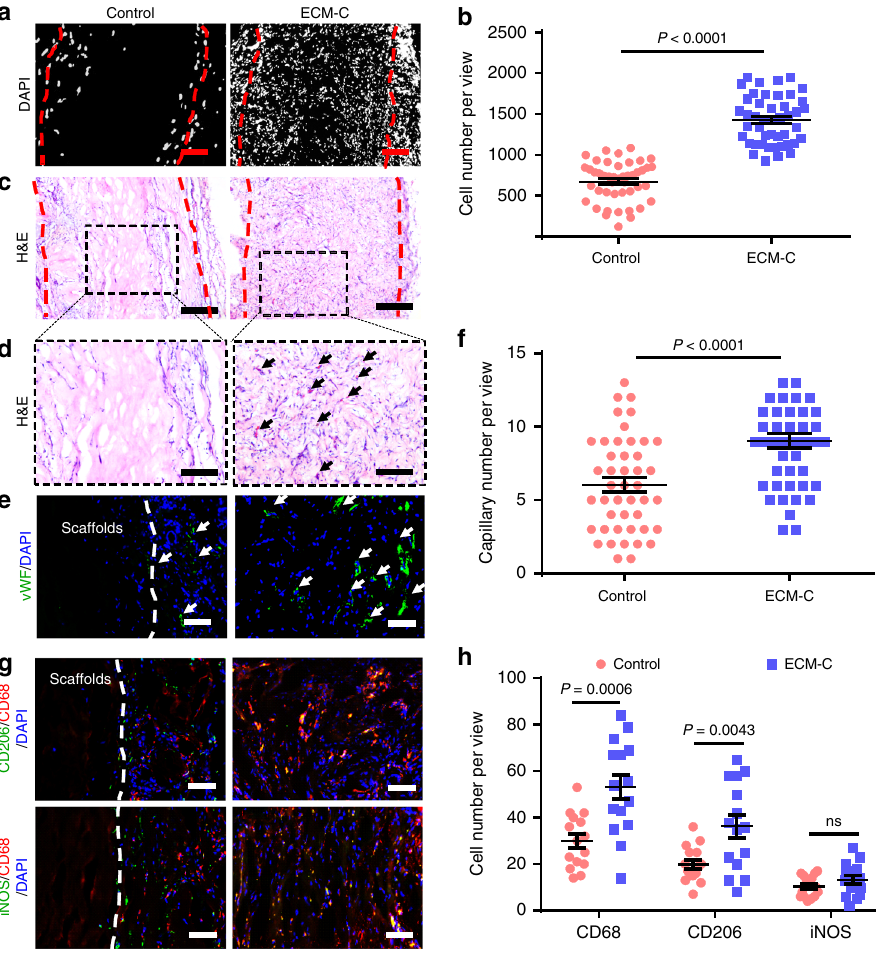
Fig. 4 Cell in fi ltration, vascularisation and immunogenic properties of ECM-C and control scaffolds in a rat subcutaneous implantation model at 2 weeks. a DAPI staining of the cross-sections showing cell in fi ltration within the scaffolds. b Quanti fi cation of cells within the scaffolds ( n = 45). c – e Optical images of cross-sections stained with H&E and immuno fl uorescently stained for vWF (green) showing cellularization and vascularisation within the scaffolds. The black and white arrows indicate the capillaries. The red dotted line indicates the edge of the scaffolds. f Quanti fi cation of capillaries within the scaffolds ( n = 45). g Macrophages were detected by co-immuno fl uorescence staining for CD206 (green, anti-in fl ammatory)/CD68 (red, pan-macrophage), and iNOS (green, pro-in fl ammatory)/CD68 (red, pan-macrophage). White broken lines indicate the border of the scaffolds. h Quanti fi cation of CD68, CD206 and iNOS-positive cells within the scaffolds ( n = 15). Images and data are representative of n = 3 individual experiments, and bar heights and error bars represent means± s.e.m. ( t -test). ( n = 5 animals per group). Statistical analysis (no signi fi cance). Scale bars: a , 100 μ m; c , 200 μ m; d , 100 μ m; e , g , 50 μ